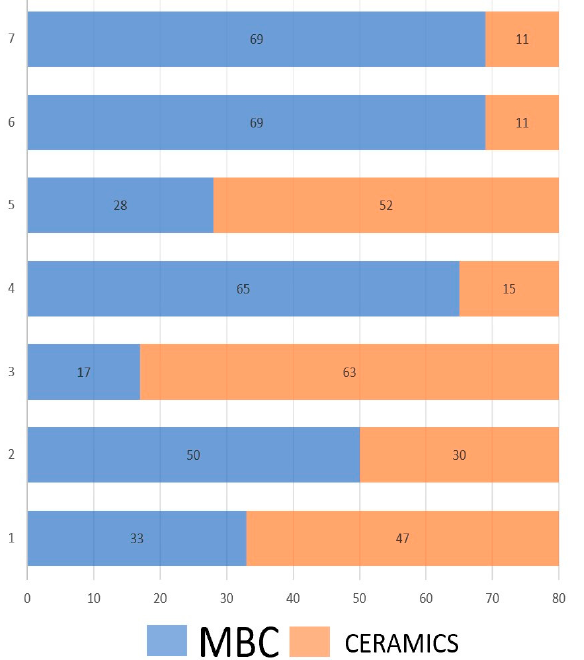
Figure 10. Results of test C—comparison of two decorative claddings: MBC; ceramic casting.